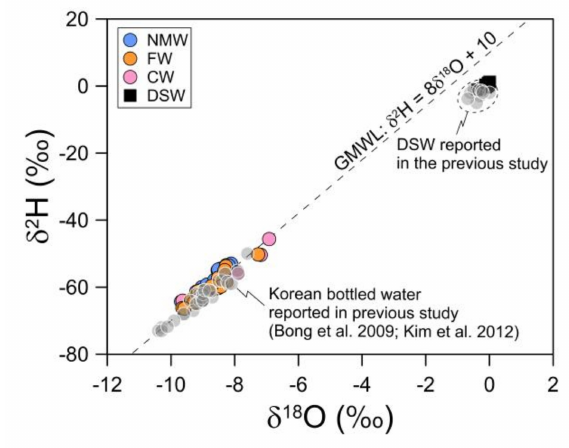
Figure 6. Plot of δ 18 O and δ 2 H values for four types of Korean bottled water samples along with previous studies